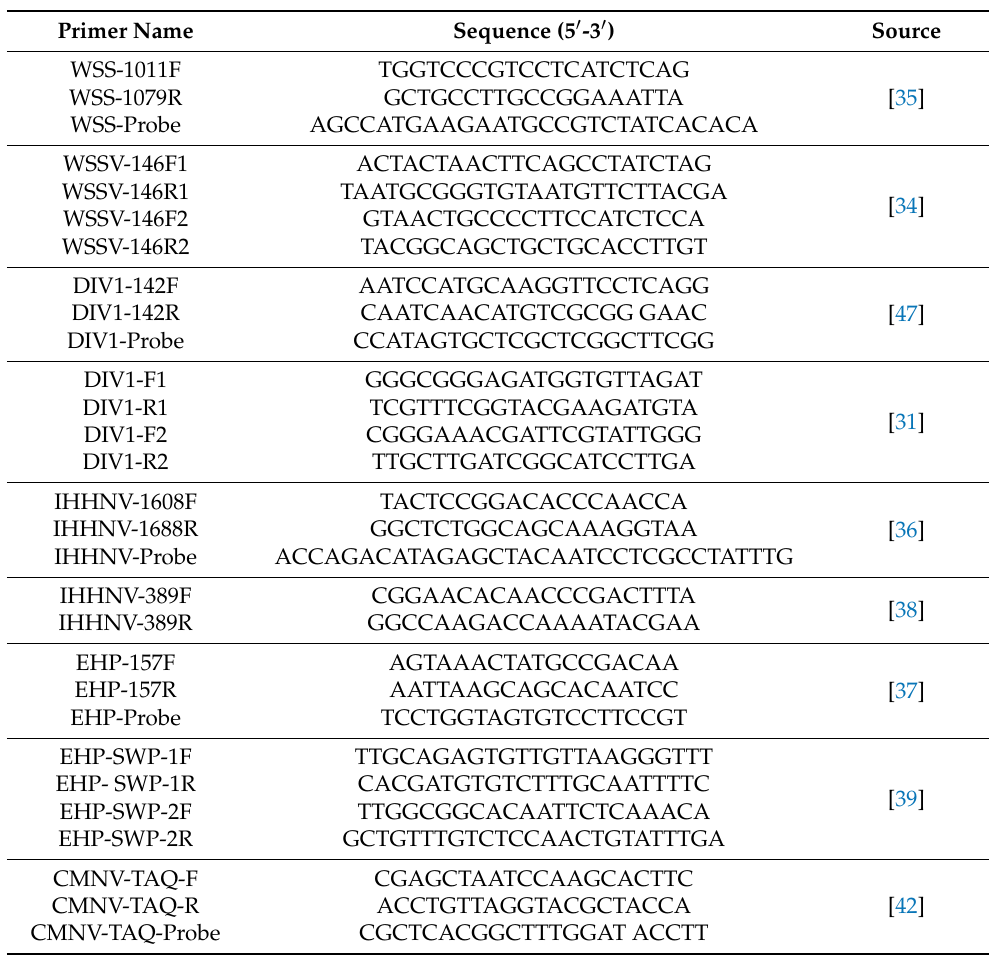
Table 1. Primer sequences were used in this study. Primer